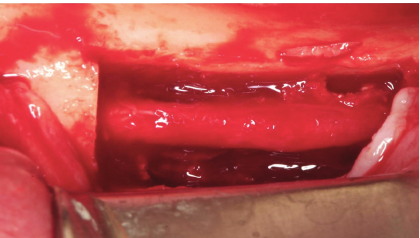
Figure 10: Suture.